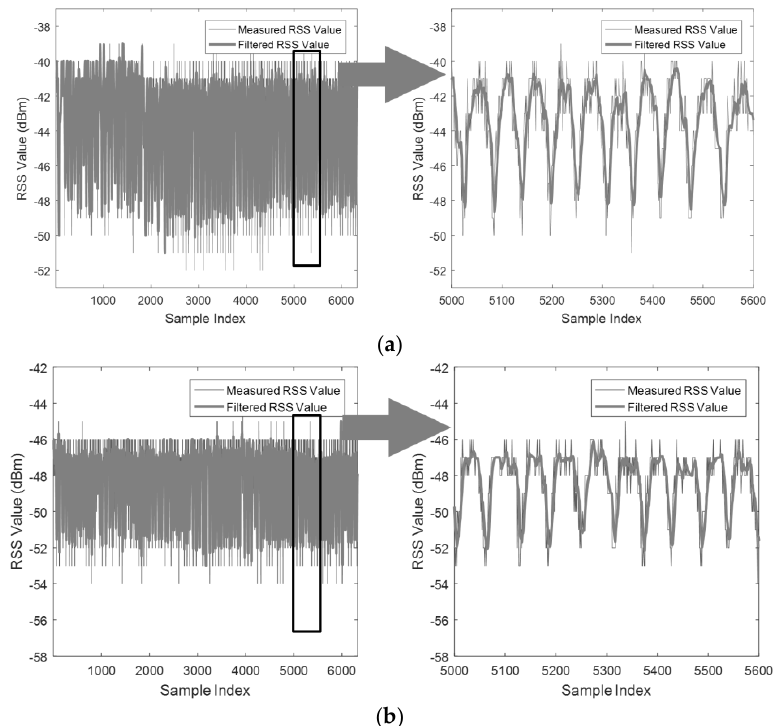
Figure 4. The RSS measurement when a pedestrian periodically walks across the LOSLs at a speed of 30 cm/s in ( a ) Case 1 and ( b ) Case 2.